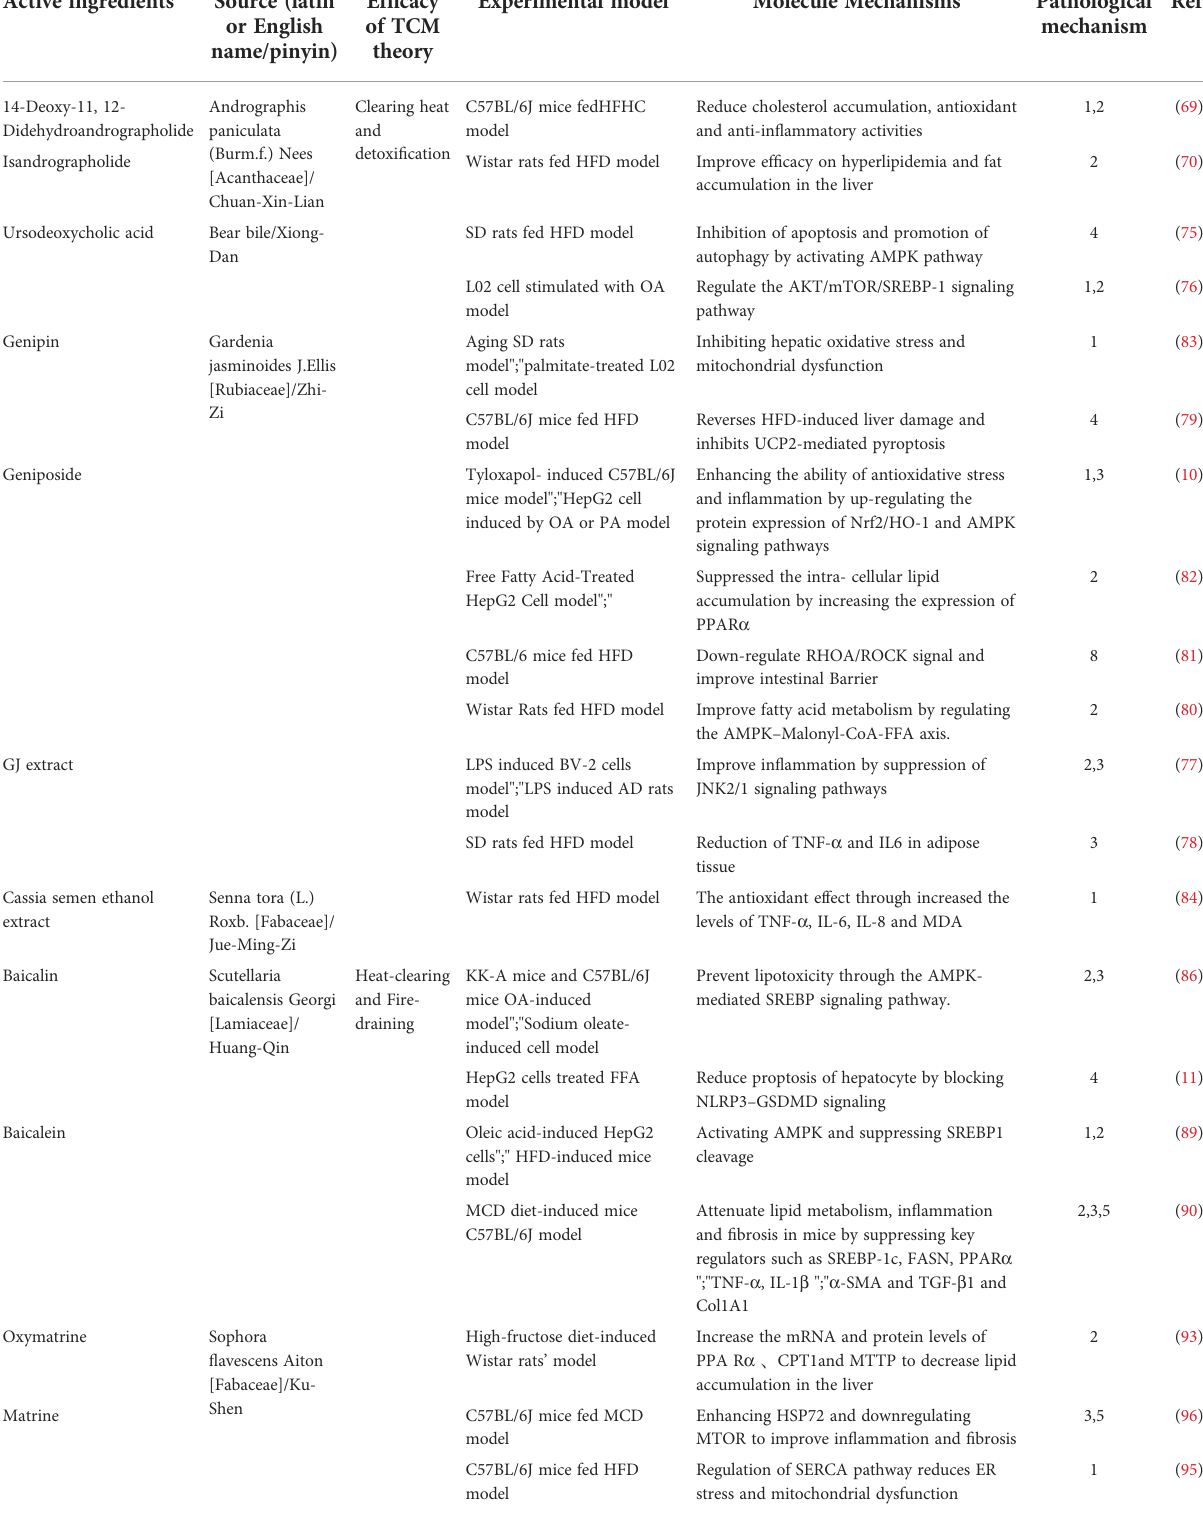
TABLE 3 Main mechanisms of CHM treating NAFLD and its complications by Heat-Clearing (Qing Re). Active